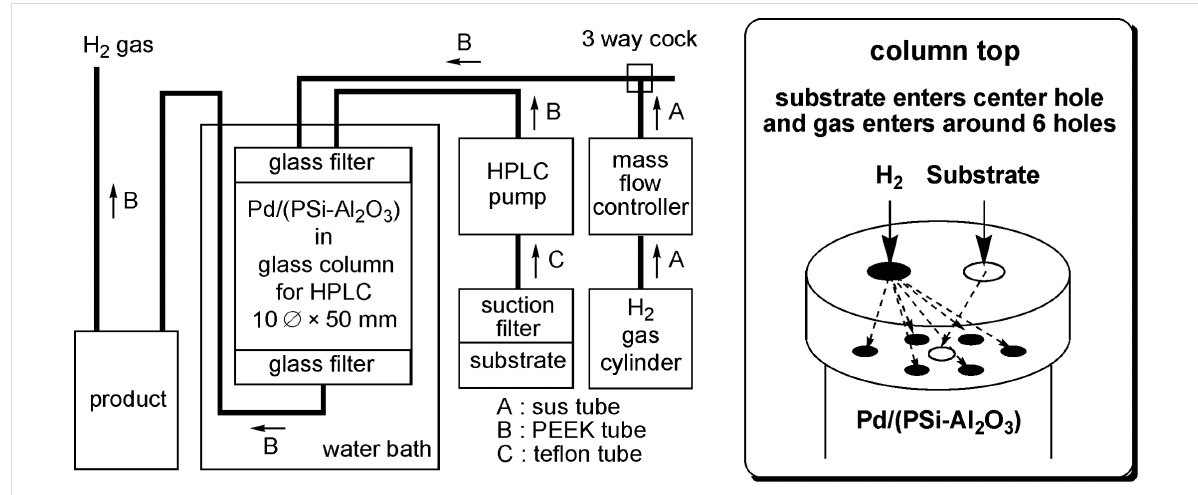
Figure 1: Schematic diagram of the continuous flow reactor (left) and the column top